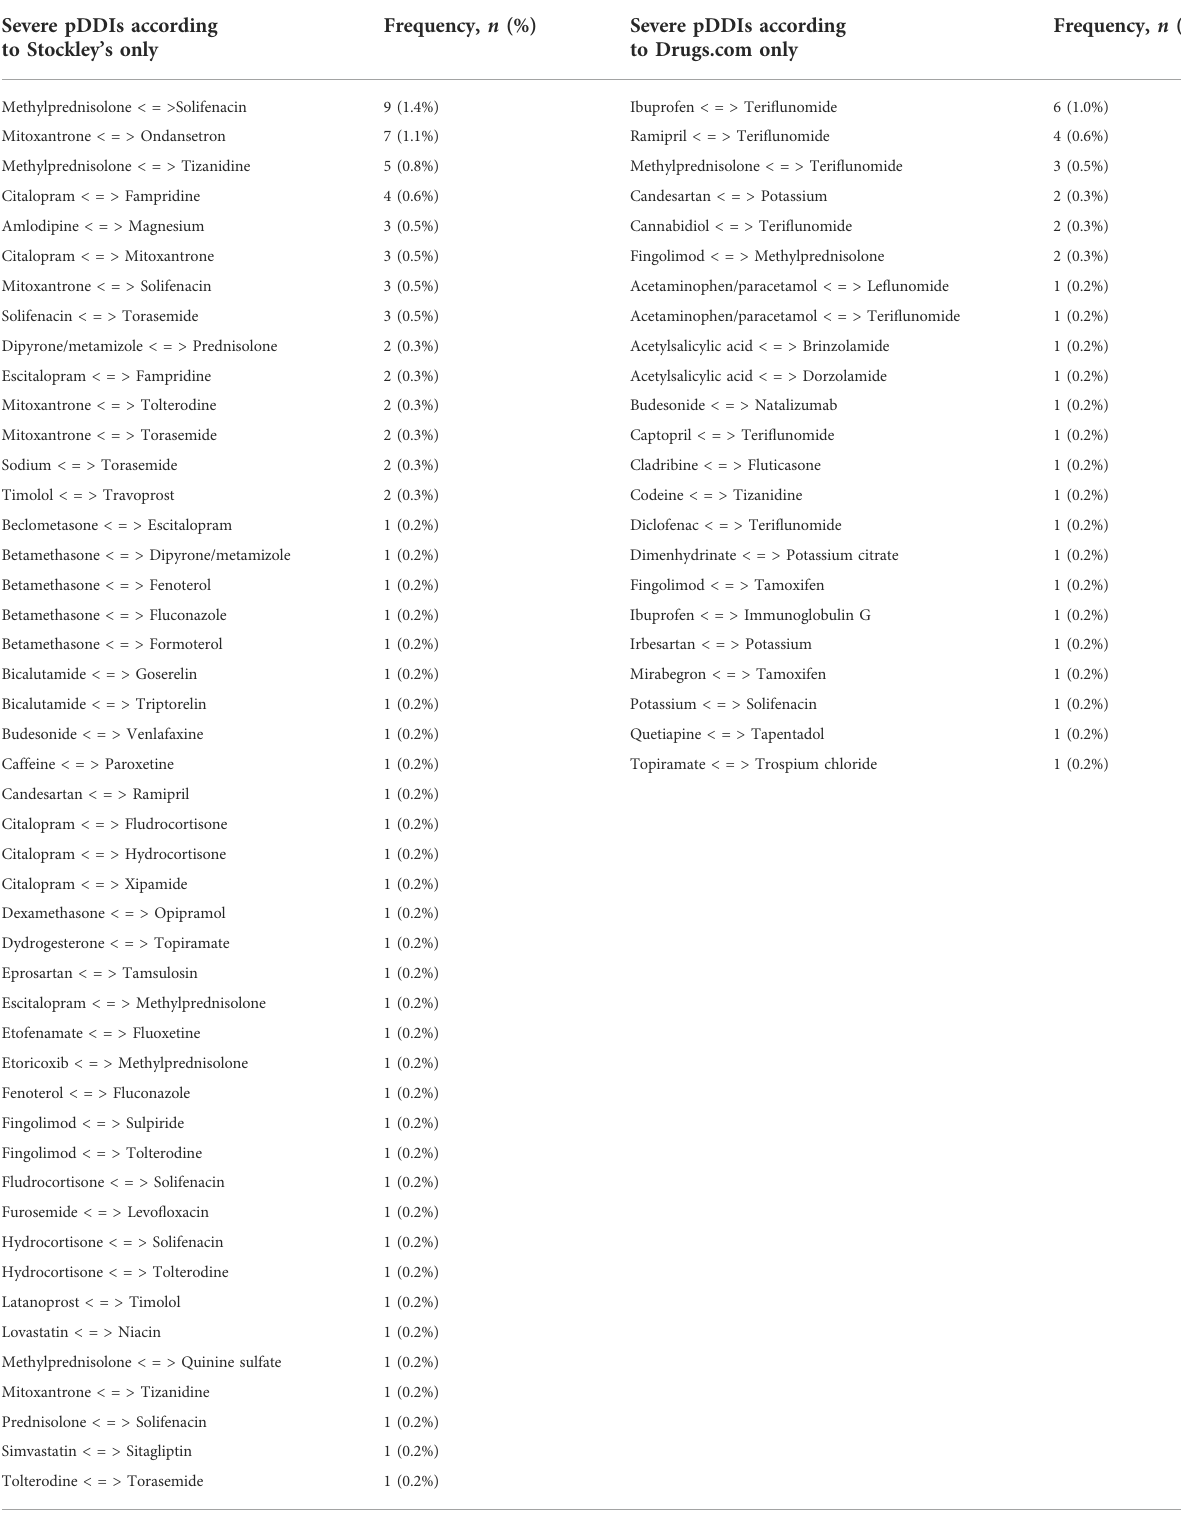
TABLE 3 Potential drug-drug interactions detected in only one database and classi fi ed as severe. Severe pDDIs according to Stockley ’ s